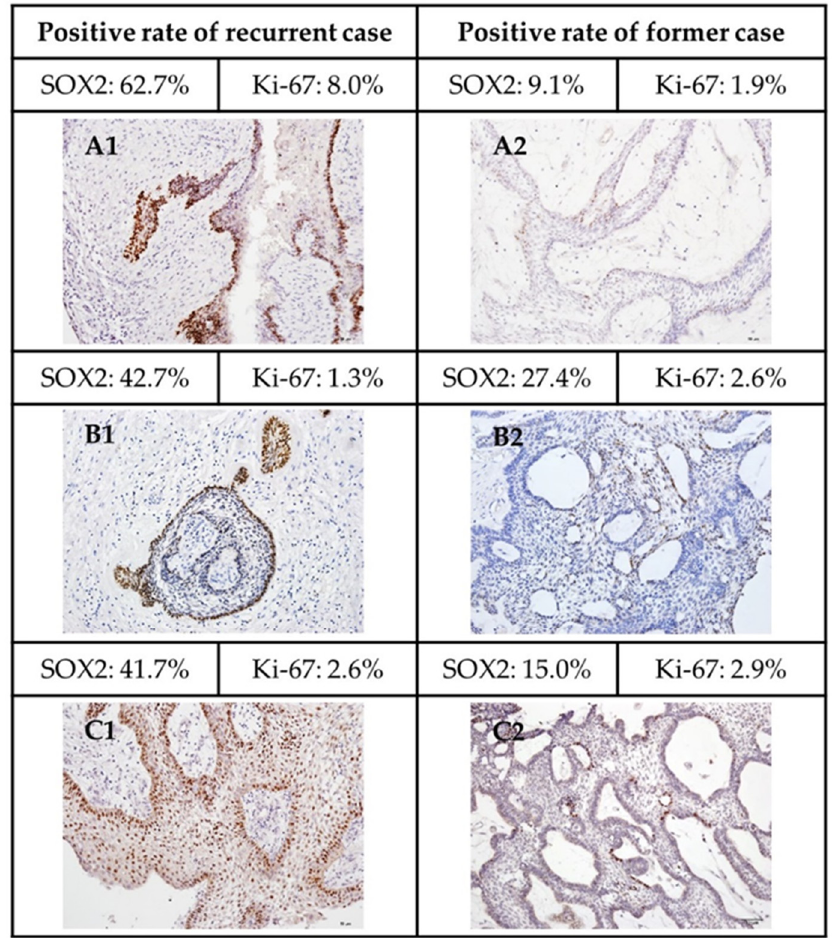
Figure 5. SOX2 and Ki-67 IHC labeling index in three paired cases of primary and recurrent lesions in three patients. The representative photographs were taken from three patients’ primary and recurrent lesions. ( A1 : recurrent and A2 : primary lesions of patient 1; B1 : recurrent and B2 : primary lesions of patient 2; C1 : recurrent and C2 : primary lesions of patient 3)